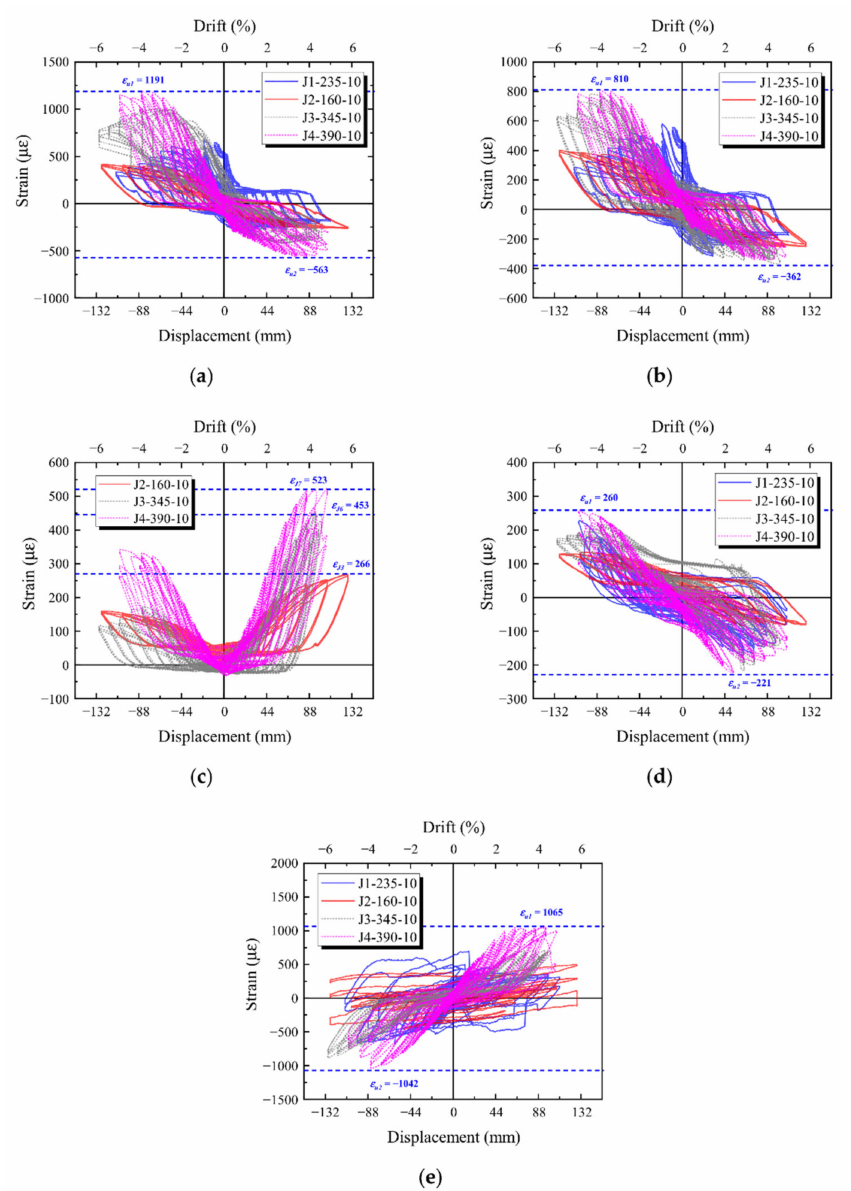
Figure 11. Strain–displacement curves of the specimens: ( a ) Strain of the longitudinal reinforcement in the beam section 1; ( b ) Strain of the longitudinal reinforcement in the beam section 2; ( c ) Strain of the stirrups in the beam; ( d ) Strain of the longitudinal reinforcement in the column; ( e ) Strain of the formed steel